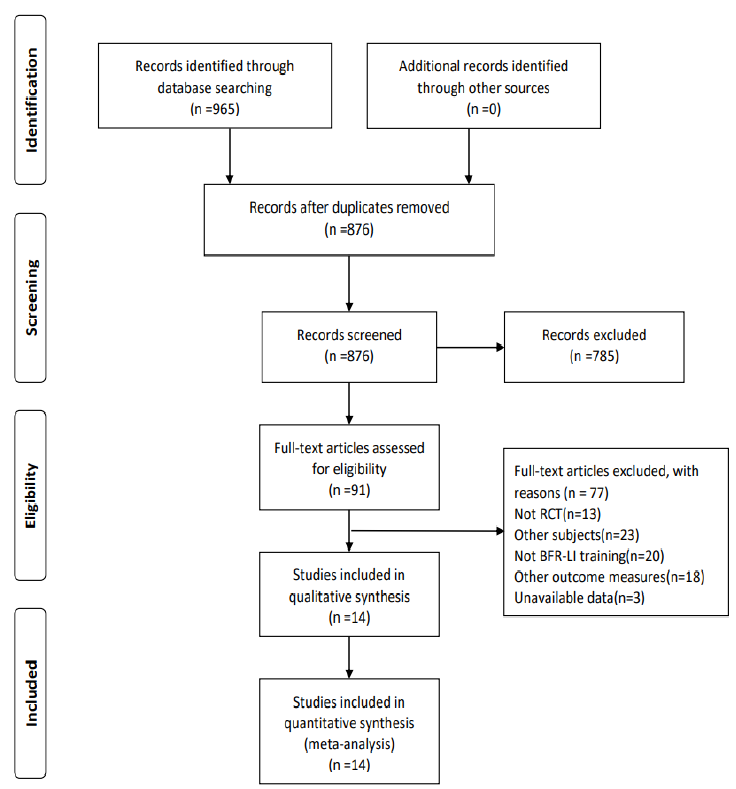
Figure 1. Flow chart of literature screening.